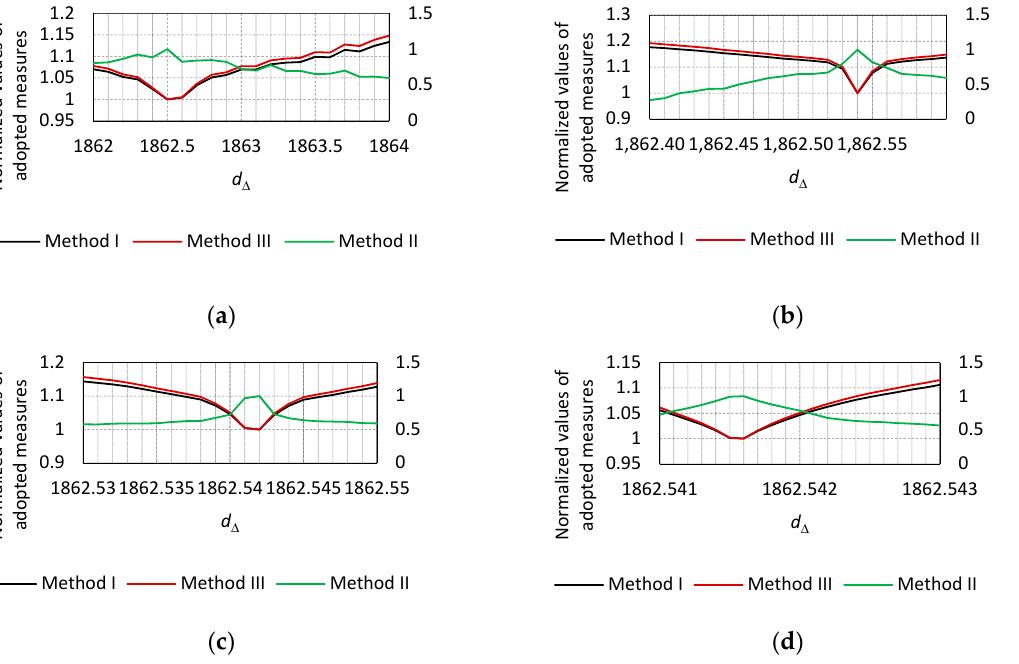
Figure 34. The normalized values of the adopted measures (method I, II and III) calculated in domain of image line length d ∆ for the accuracy ( a ) ∆ = 0.1, ( b ) ∆ = 0.01, ( c ) ∆ = 0.001 and ( d ) ∆ = 0.0001 (for the original image shown in Figure 7f).